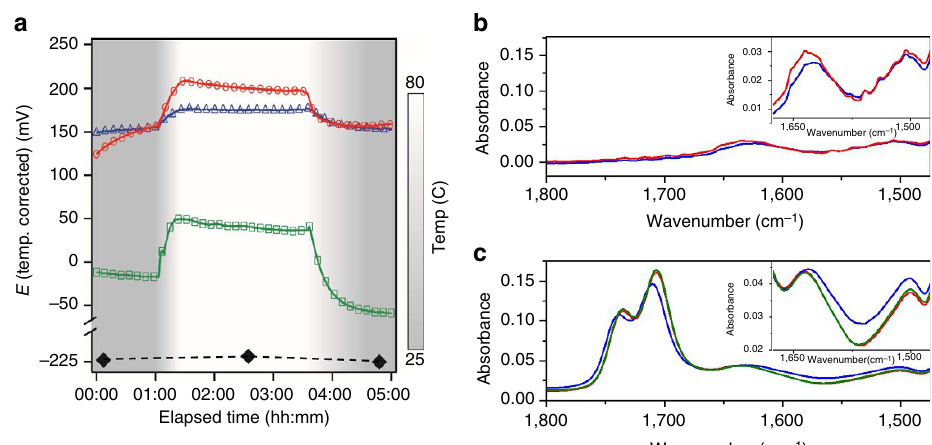
Figure 2 | Effect of temperature on the acid–base equilibria. ( a ) Potential measurements for DMSO; neat (black diamonds), with 1M chloride salts (green, squares), with 3 vol% FAH (red, circles) and with 1M iodide salts and 3 vol% FAH (blue, triangles), temperature indicated by the background gradient with the scale bar to the right. ( b ) In situ Fourier transform infrared (FTIR) data of 1.5M solution of chloride salts in DMSO with no FAH added and ( c ) with FAH added; data are taken initially at 25 (cid:2) C (red), at 55 (cid:2) C (blue) and then again after cooling back to 25 (cid:2) C (green). Insets are expanded to show the MA/MAH þ peaks between 1,500 and 1,650cm (cid:2) 1